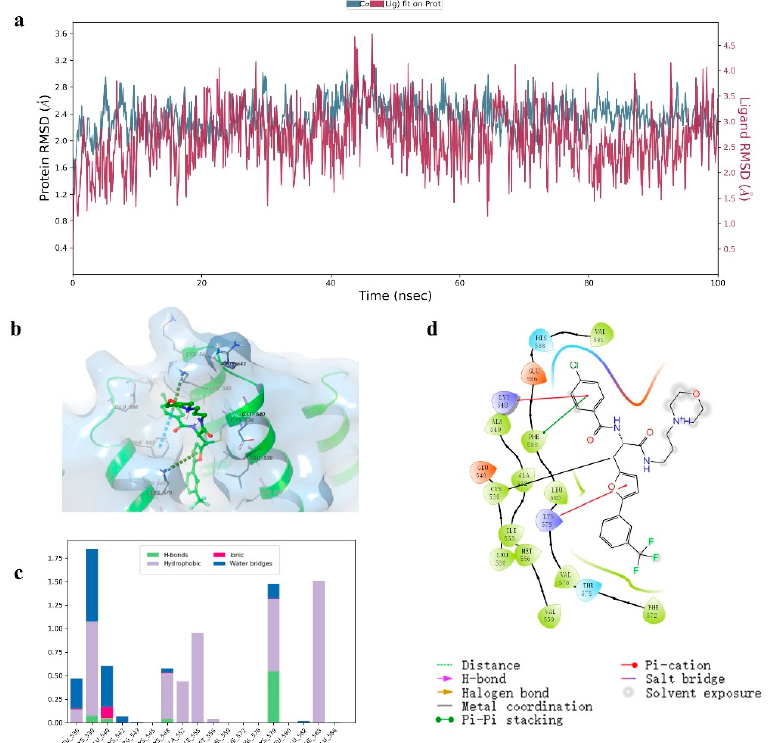
Figure 6. Compound 8 -XPO1 complex molecular dynamics result. ( a ) RMSD of proteins and small molecules. ( b ) Global view of compound 8 -XPO1 interactions. ( c ) Contribution of each amino acid residue to the binding affinity. ( d ) 2D sketch showing binding pocket detail.